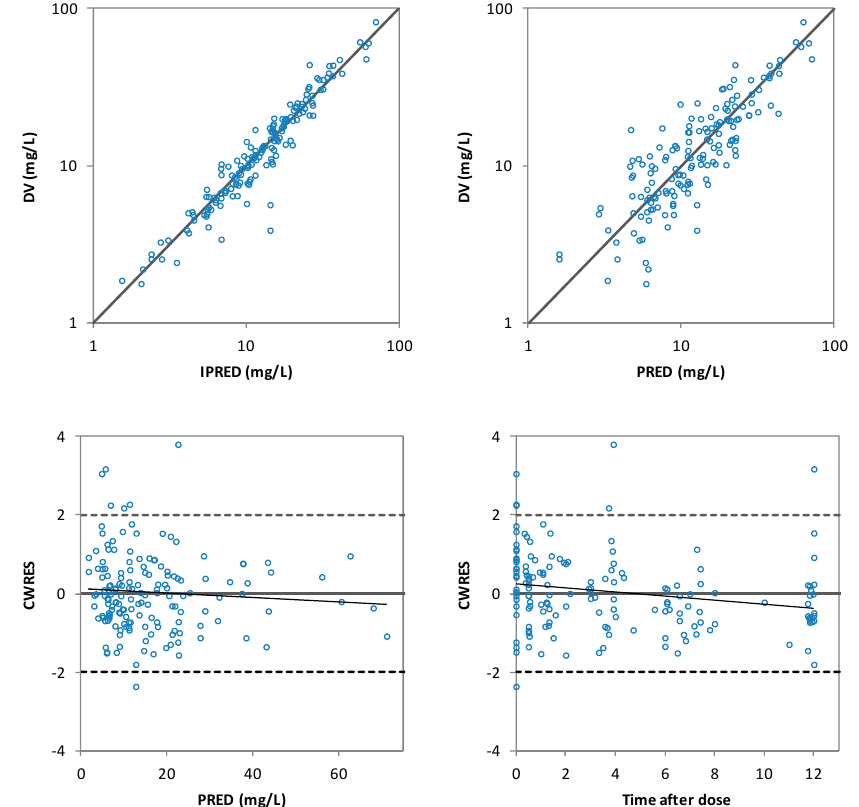
Figure 3. The goodness of fit plots of individual predicted (IPRED) versus the observed (DV) levetiracetam concentrations ( top-left ), population predicted (PRED) versus DV levetiracetam concentrations ( top-right ), conditional weighted residuals (CWRES) versus PRED ( bottom-left ) and CWRES versus time after dose ( bottom-right ) of the final model.